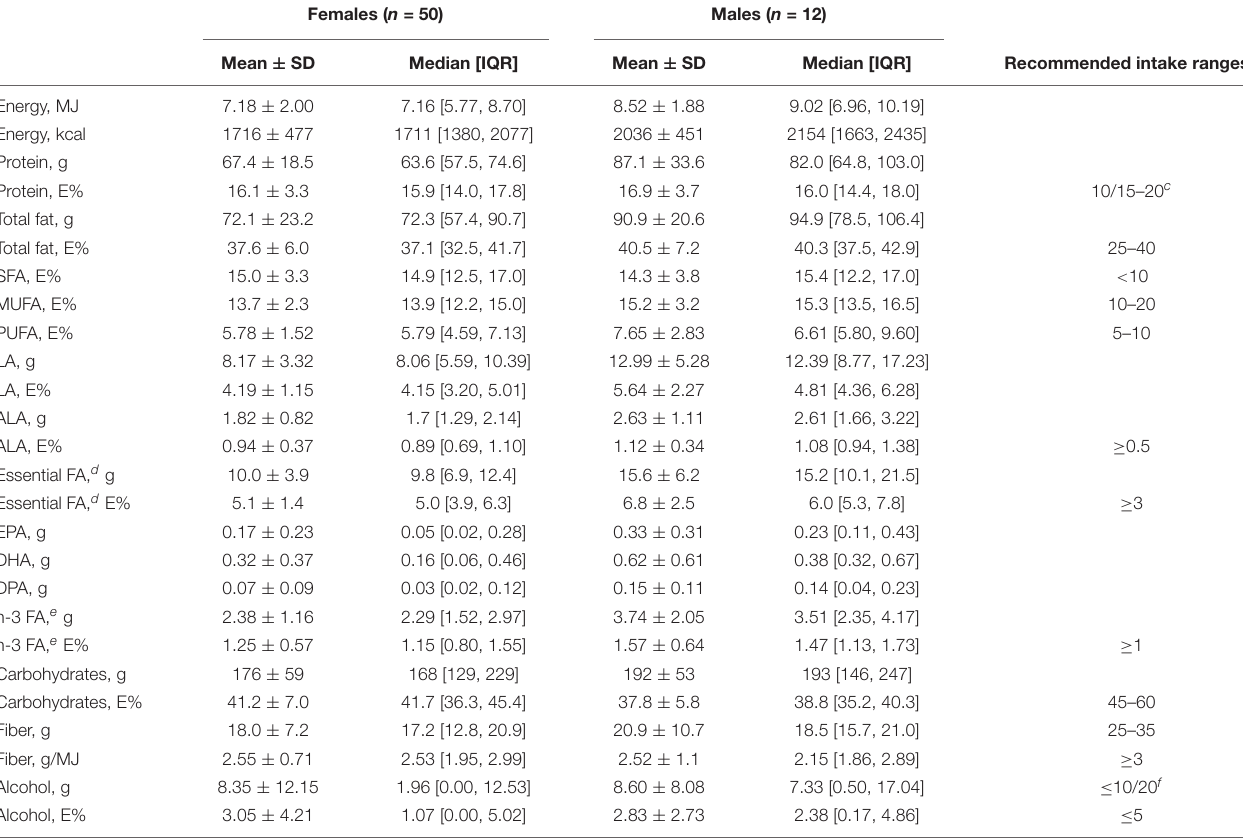
TABLE 2 | Energy and macronutrient intake in patients with rheumatoid arthritis residing in southwestern Sweden a . Females ( n =